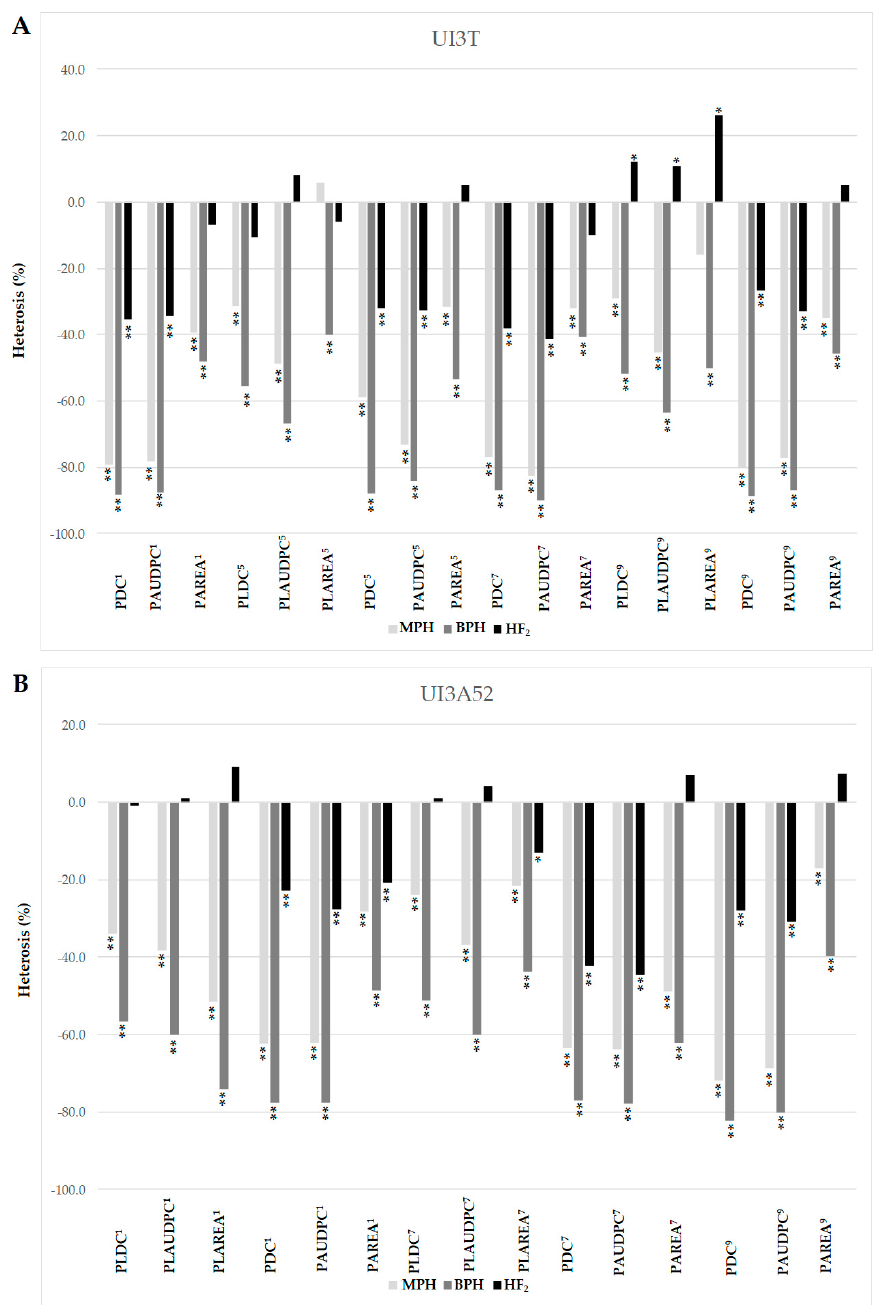
Figure 2. Estimates of mid parent (MPH), better parent (BPH) and mid-F 2 heterosis (HF 2 ) (%) for primary leaf and pod resistance to halo blight races 1, 5, 7 and 9 for the UI3T ( A ) and UI3A52 ( B ) segregating generations. MPH = mid-parent heterosis (MPH (%) = (F 1 -MP/MP) × 100); BPH = better-parent heterosis (BPH (%) = (F 1 -BP/BP) × 100); HF 2 = mid-F 2 heterosis (HF 2 = (2F 2 − P 1 − P 2 ) × 100/(P 1 + P 2 )). Heterosis significance was determined with the Wynne et al. [63] “ t ” test. Single and double asterisks indicate statistical significance levels at p ≤ 0.05 and p ≤ 0.01, respectively. PDC = pod disease score; PAUDPC = pod area under the disease progress curve; PAREA = size of the lesion on pods; PLDC = primary leaf disease score; PLAUDPC = primary leaf area under the disease progress curve; PLAREA = size of the lesion on primary leaves. Numerical superscripts refer to the race tested. The two primary (unifoliate) leaves of bean plants were inoculated with races 5 and 9 in UI3T and with races 1 and 7 in UI3A52 segregating generations.